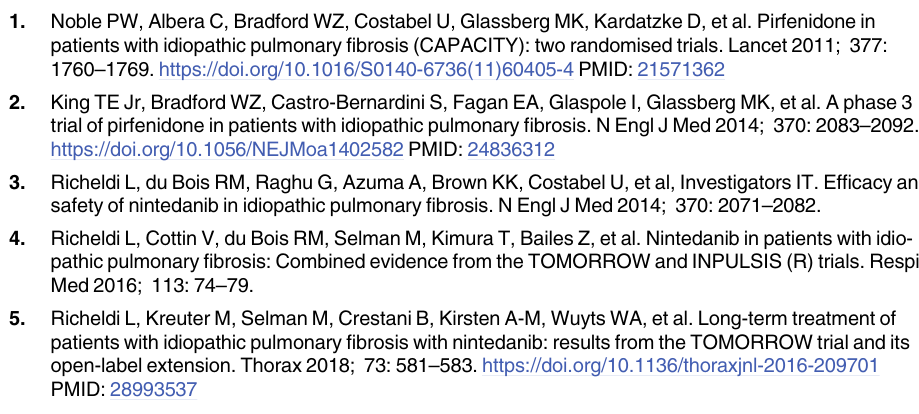
S2 Table. Univariate hazard ratio for mortality and PFS. S3 Table. Multivariate hazard ratio for mortality and PFS (adjusted on age, sex, height, NYHA and FVC at baseline). S4 Table. Difference of annual rate of decline in DLCO according to diagnostic subgroups.